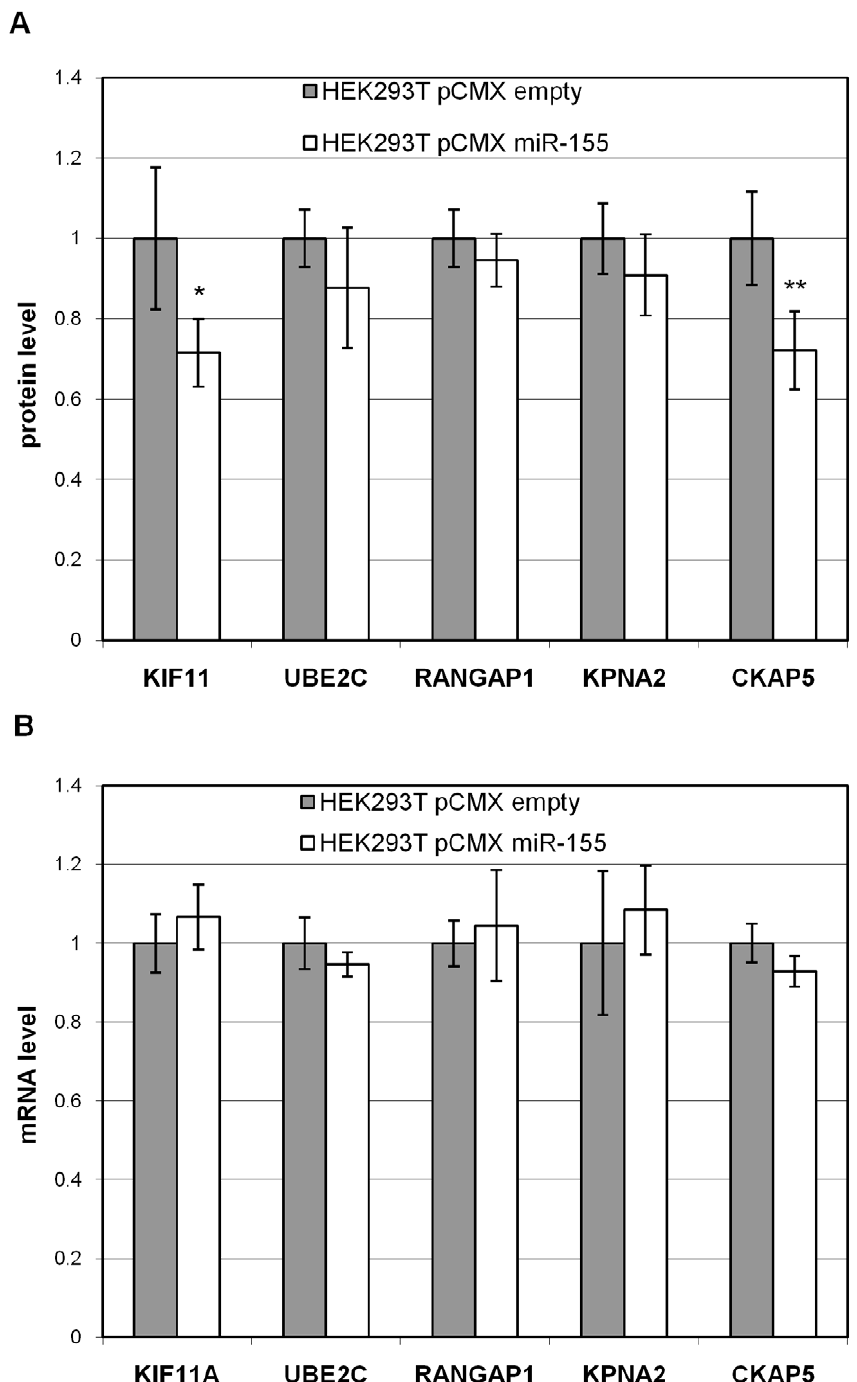
Figure 3. Western blot analysis and qRT-PCR analysis of five selected target proteins. The protein levels A or mRNA levels B of the miR- 155 overexpression (HEK293T pCMX miR-155) are compared to the control (HEK293T pCMX empty). The values of the controls are set to 1. The standard bars show the standard deviation between the four A or three B biological replicates. *: Student’s t-test , 0.05; **: Student’s t-test , 0.01.